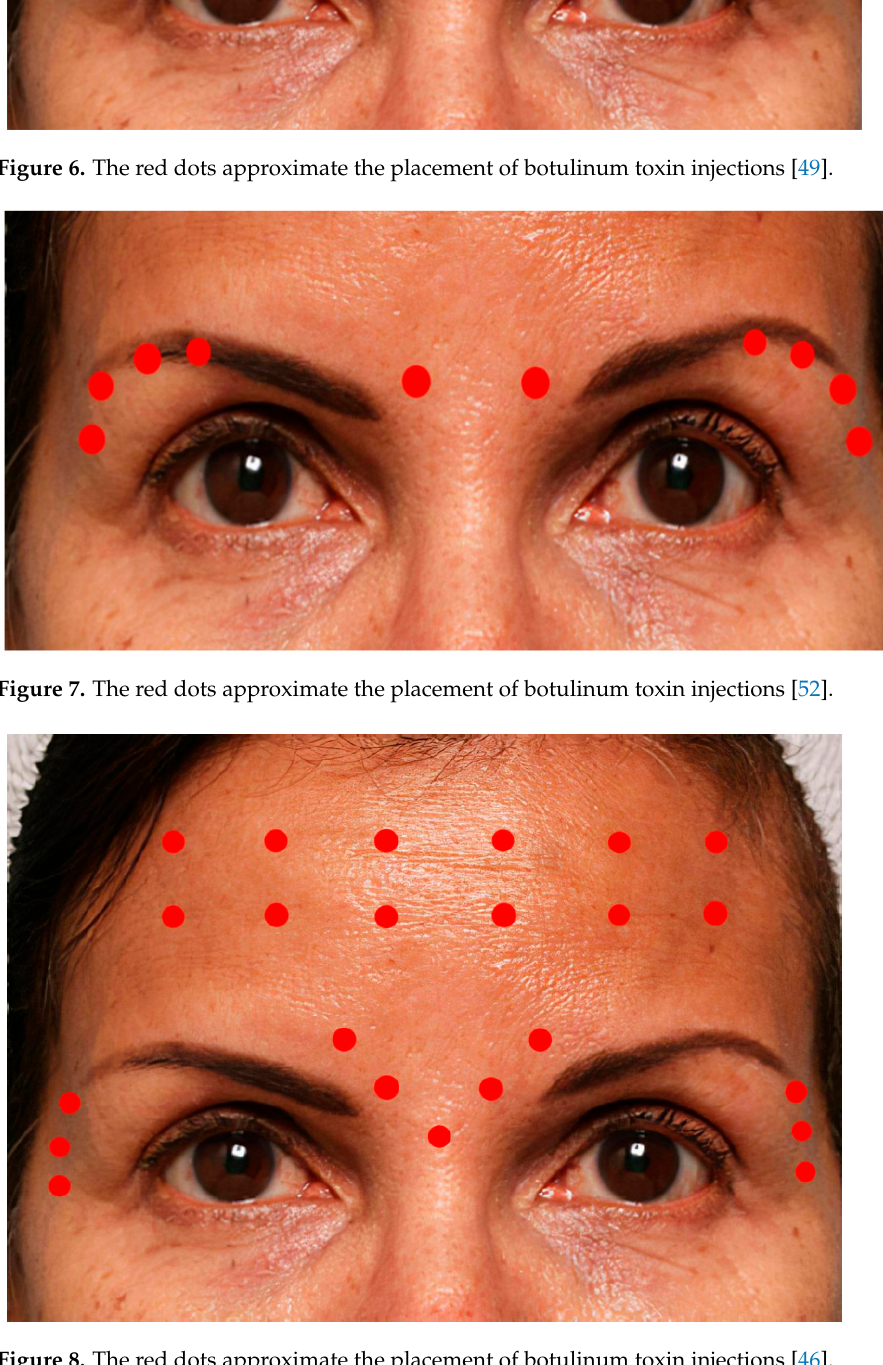
Figure 8. The red dots approximate the placement of botulinum toxin injections [46].